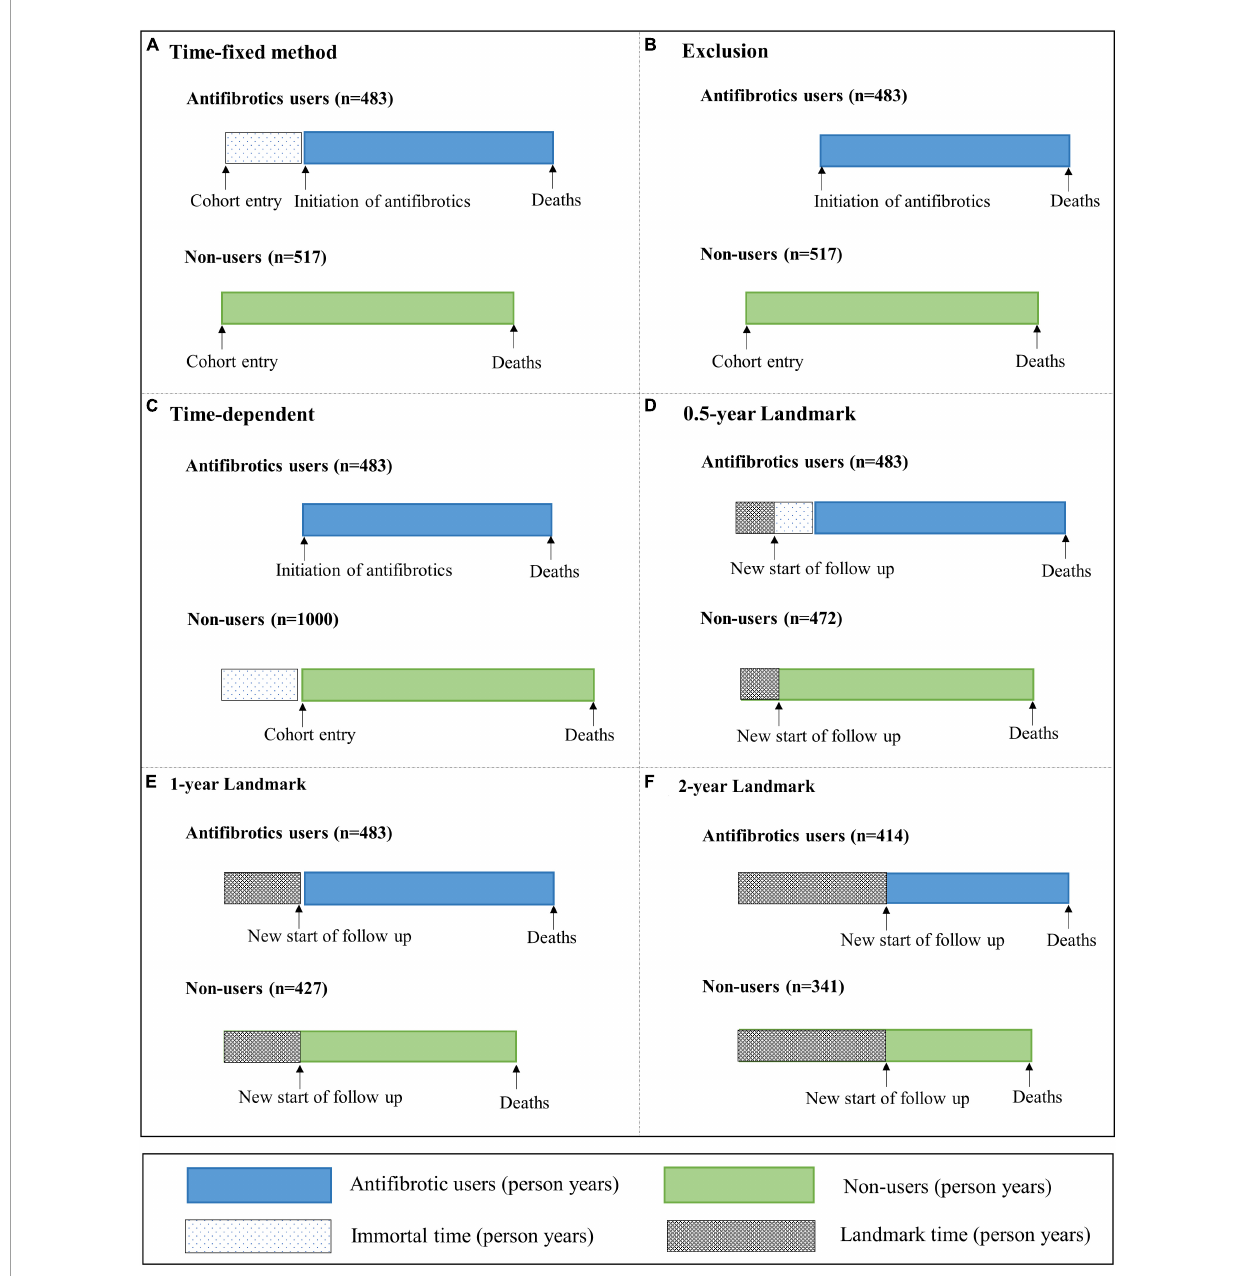
FIGURE1 Illustration of allocating immortal time in four different methods. (A) Time–fixed method, (B) exclusion method, (C) time–dependent method, and (D–F) landmark method. For the time–fixed method, the immortal time was ignored and incorporated in the treated group. For the exclusion method, the immortal time was excluded from the study. For the time–dependent method, the immortal time was switched into the control group, with an additional 483 subjects being added into the control group. For the landmark method, 0.5, 1, and 2 years landmarks excluded 45, 90, and 245 simulated subjects who had died prior to this time point, respectively. Immortal time was defined as the time from cohort entry to the initiation of antifibrotic therapy. Landmark time was defined as a fixed time point, which was the same for all